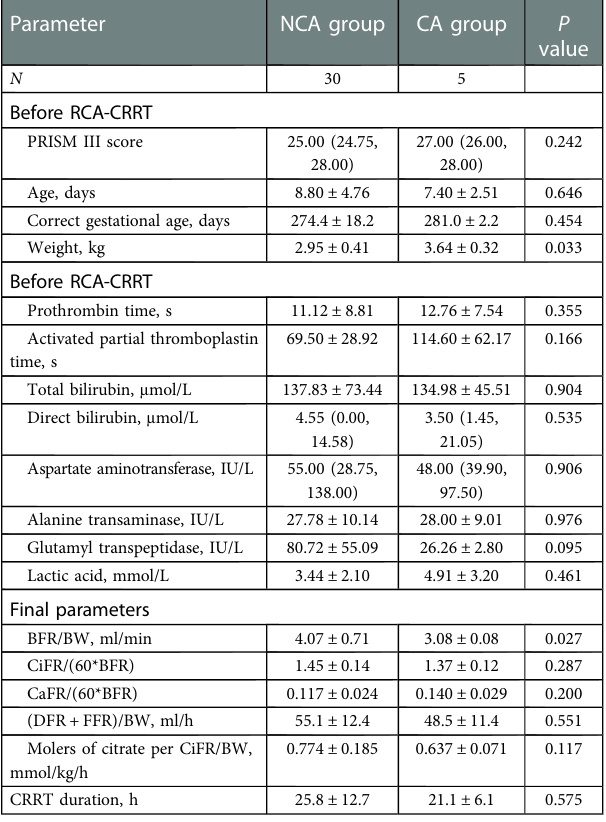
TABLE 4 Comparison of CA and NCA group after